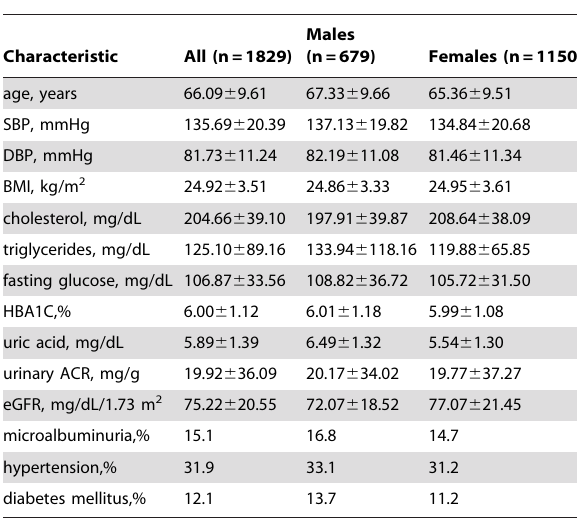
Table 1. Baseline characteristics of study subjects.